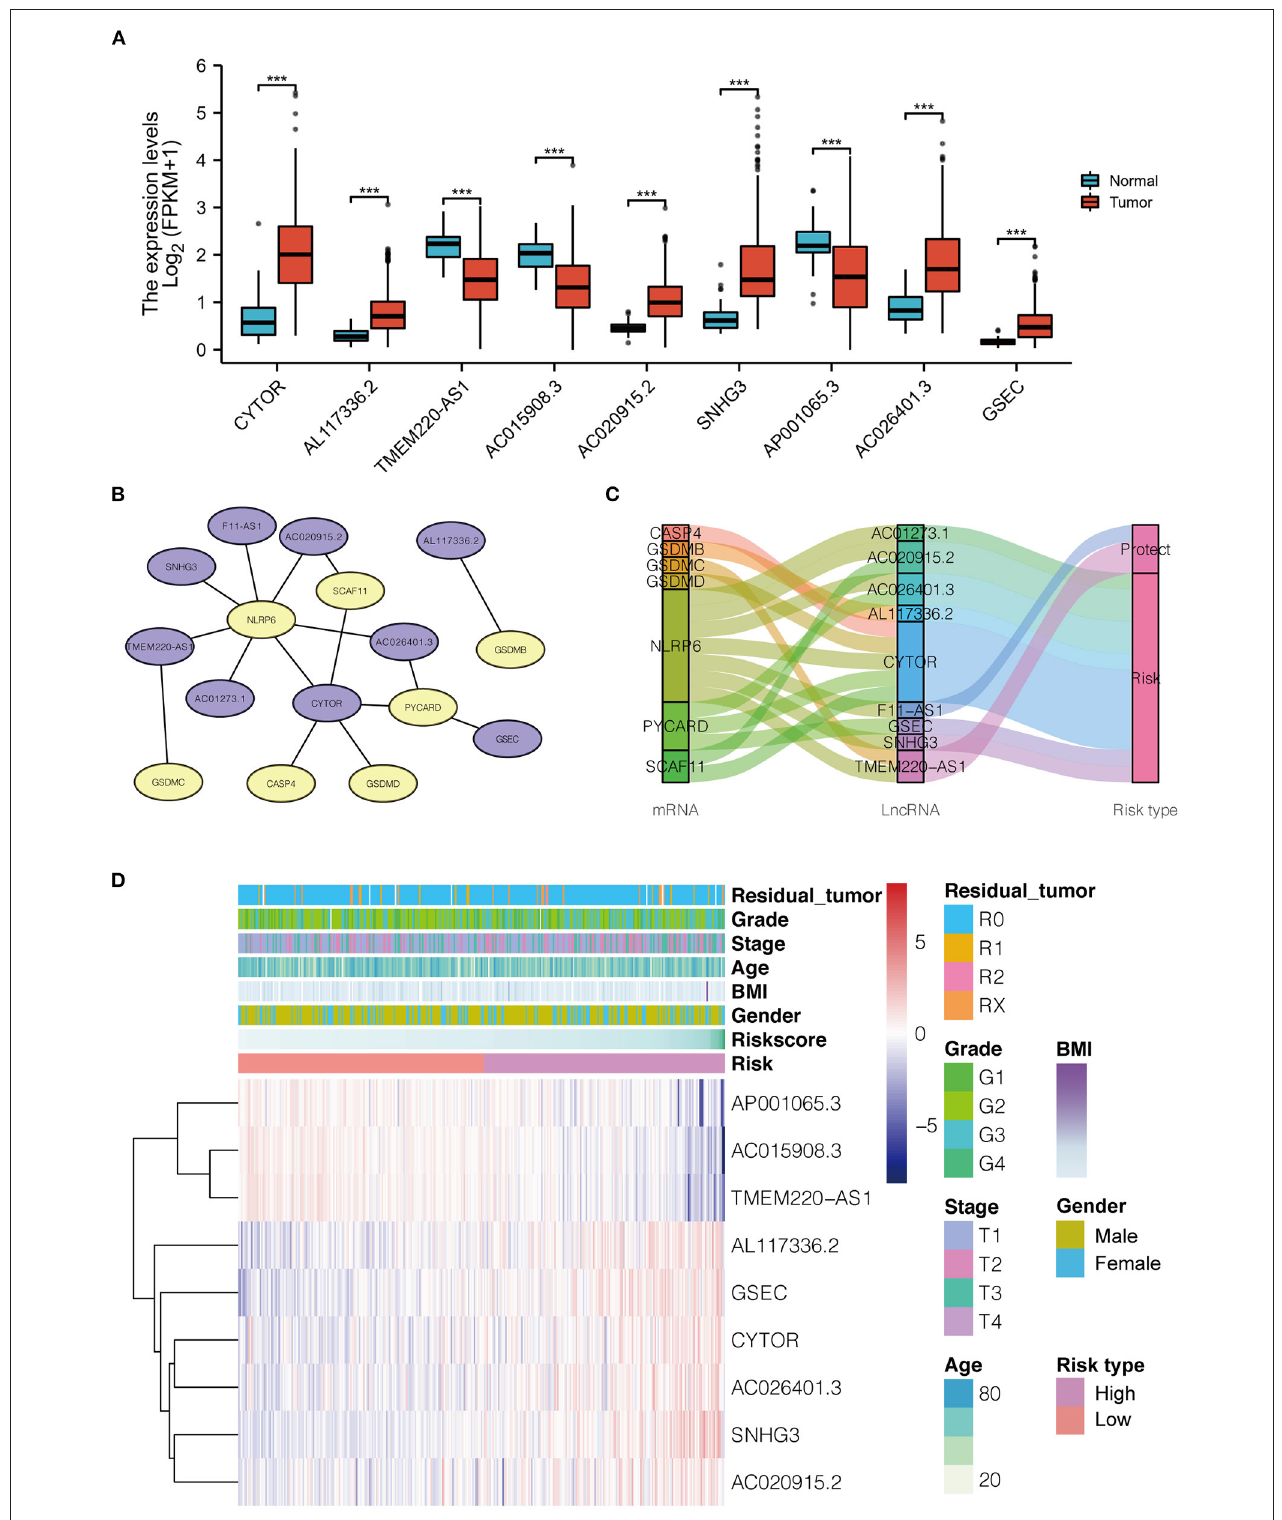
FIGURE 2 | (A) The distribution of 9 pyroptosis-related lncRNA expression patterns in tumor and adjacent normal liver tissues based on LIHC-TCGA dataset. (B) The co-expression network of the 9 pyroptosis-related lncRNAs-mRNAs with prognostic value was constructed and visualized using Cytoscape (Purple represents lncRNA, and yellow represents mRNA). (C) Sankey diagram for pyroptosis-related lncRNAs-mRNAs co-expression network. (D) Heatmap for the expressions of